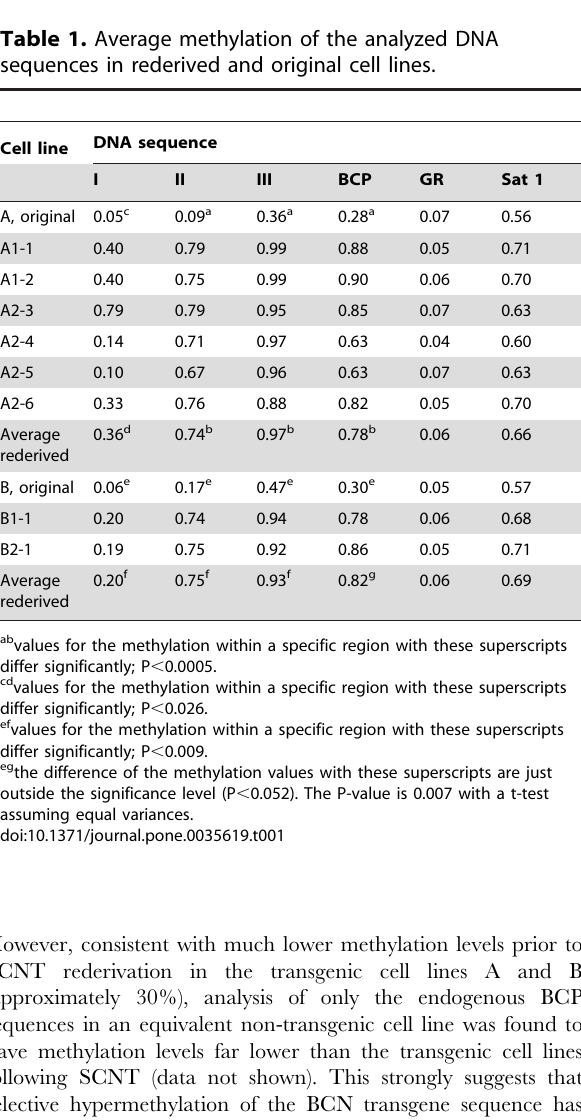
Table 1. Average methylation of the analyzed DNA sequences in rederived and original cell lines.